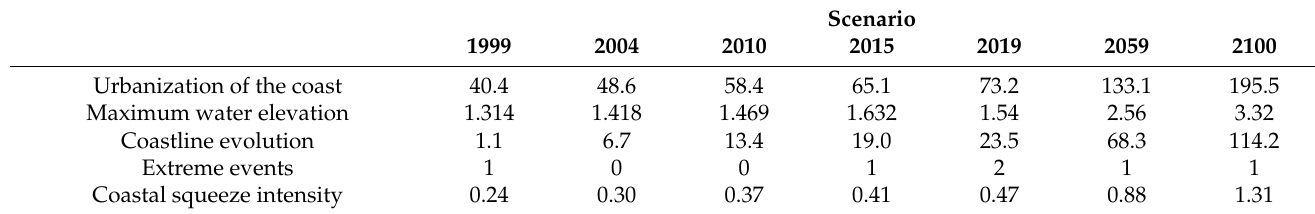
Table 11. Degree of coastal squeeze for each scenario.